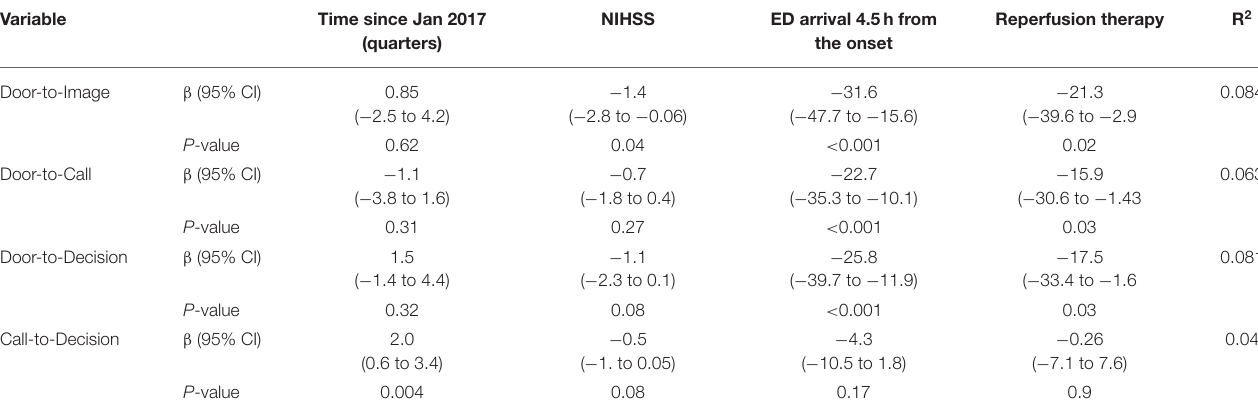
TABLE 2 | Estimated effects on treatment timings of the experience, NIHSS, ED arrival within 4.5h and the use of reperfusion